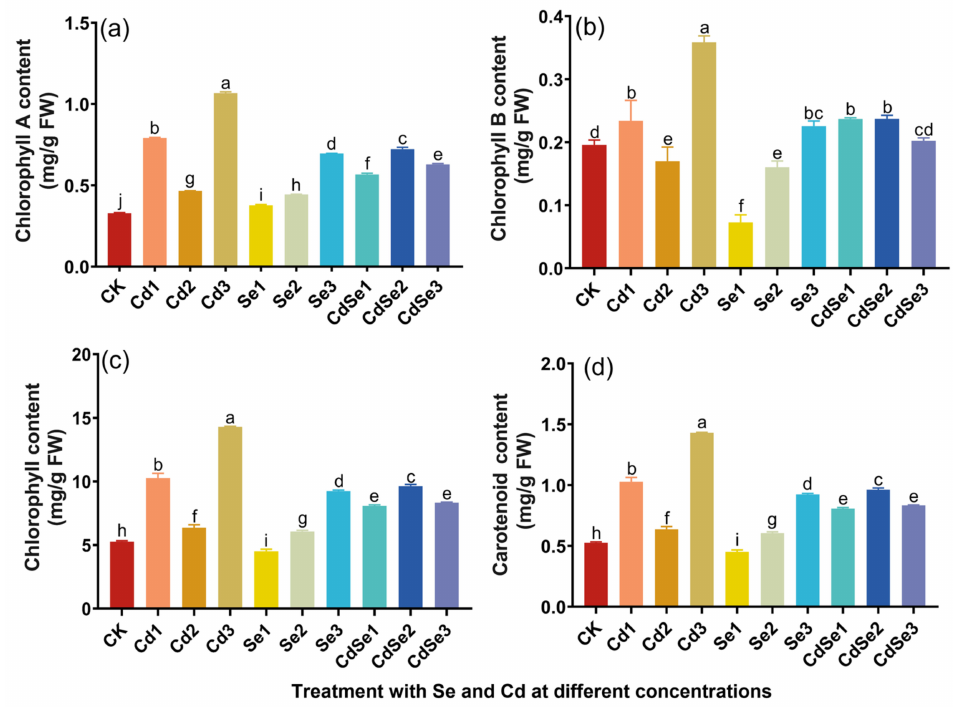
Figure 3. Changes in photosynthetic pigment content in mustard with different concentrations of Se and Cd. The error bar represents the standard deviation. The lowercase letter a to j on the bar reflects the 5% significance level. ( a ) Chlorophyll A content in seedling leaves; ( b ) chlorophyll B content in seedling leaves; ( c ) total chlorophyll content in seedling leaves; and ( d ) carotenoid content in seedling